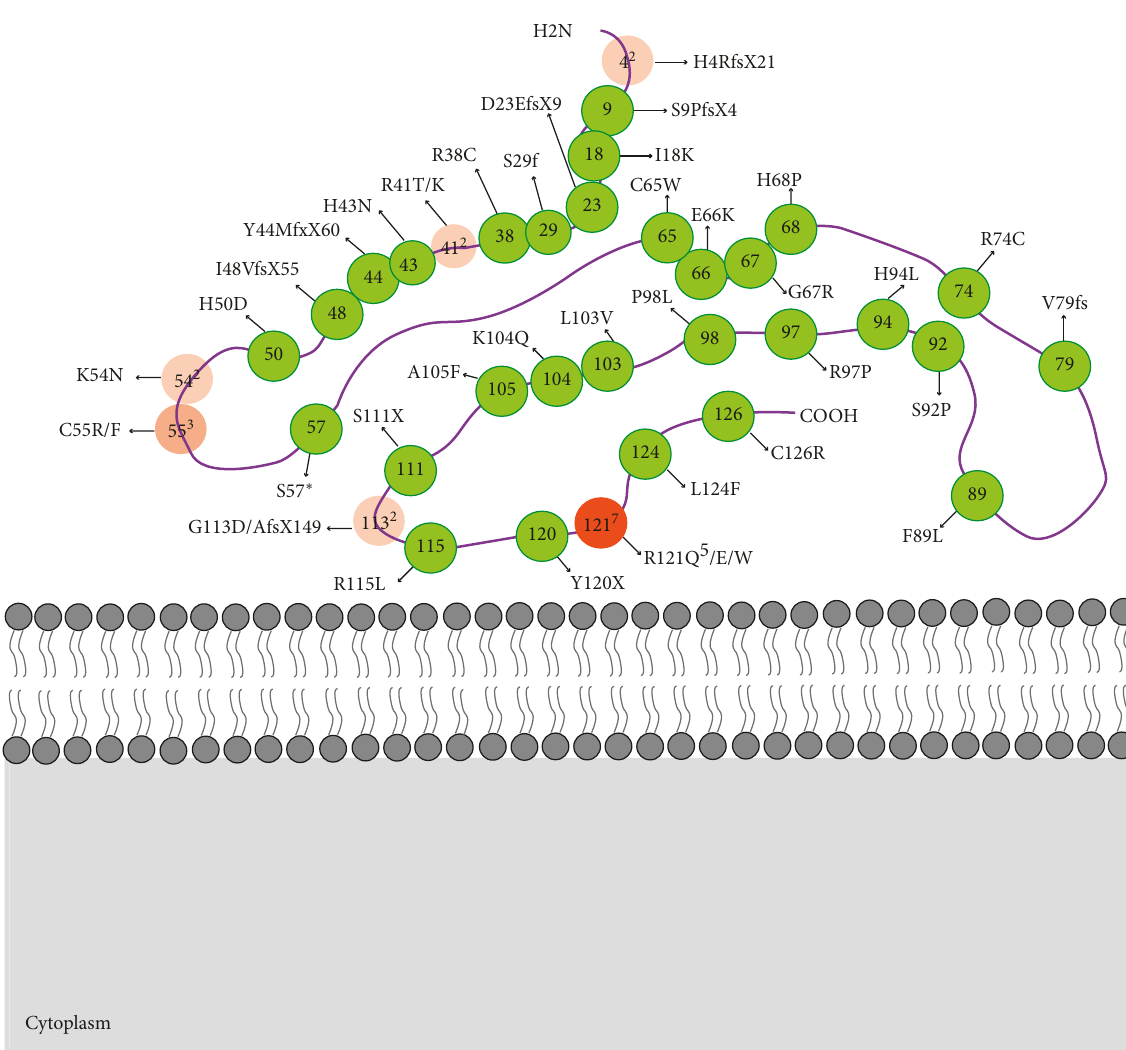
Figure 2: Schematic diagram of the Norrin protein shows the location of the mutations within the protein domains. Superscript number means the reported times of the same or different mutations at a certain site. The color of the mutations which were reported more than one time was recolored as orange. The opacity varied with the reported frequency of the